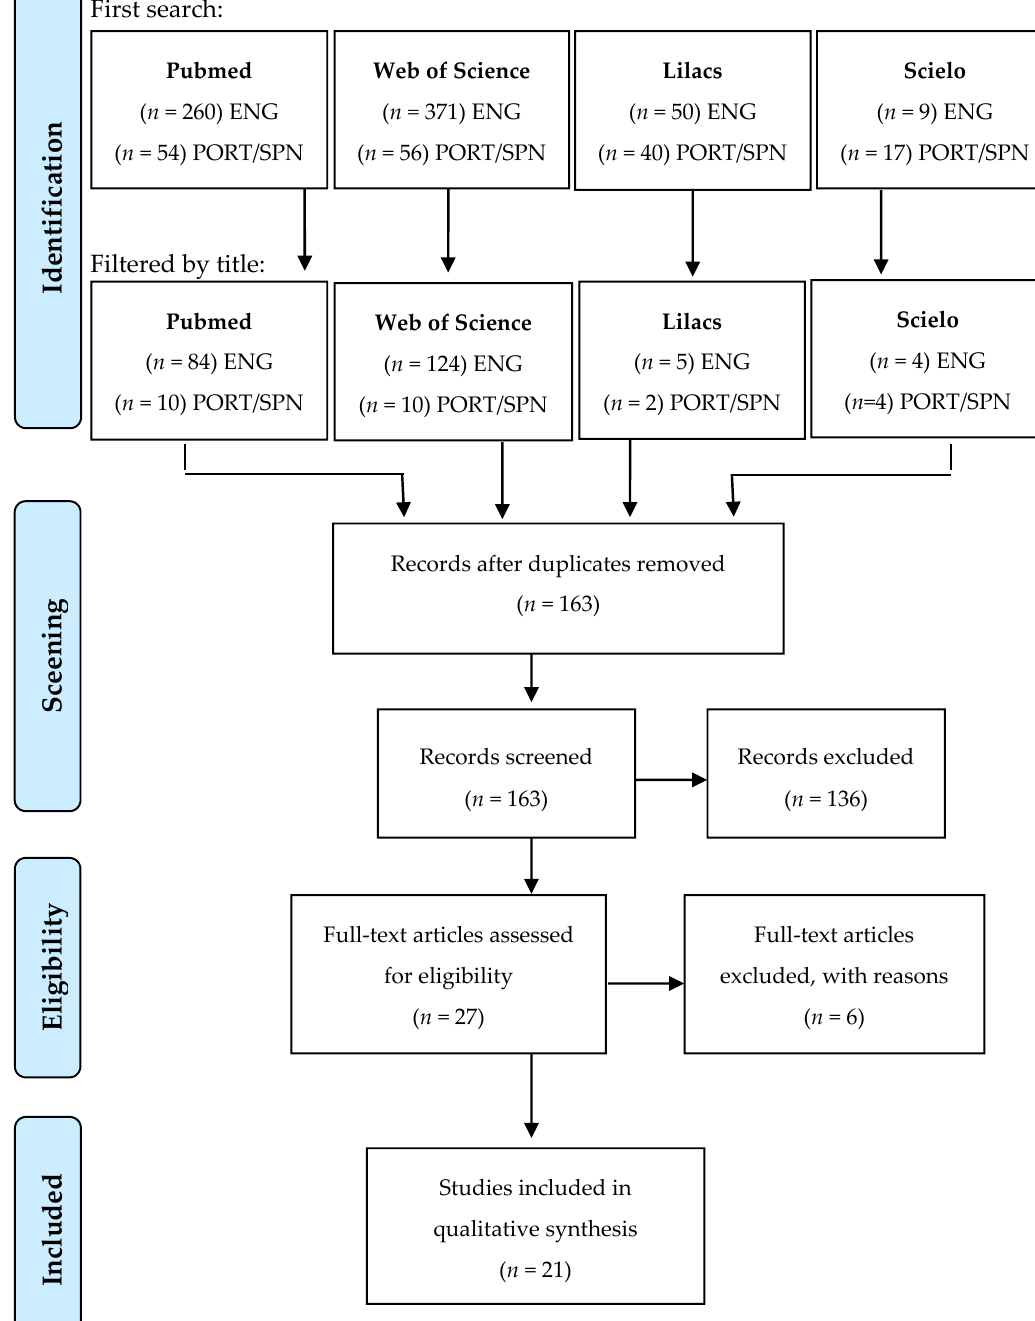
Figure 1. Flow chart of study selection.